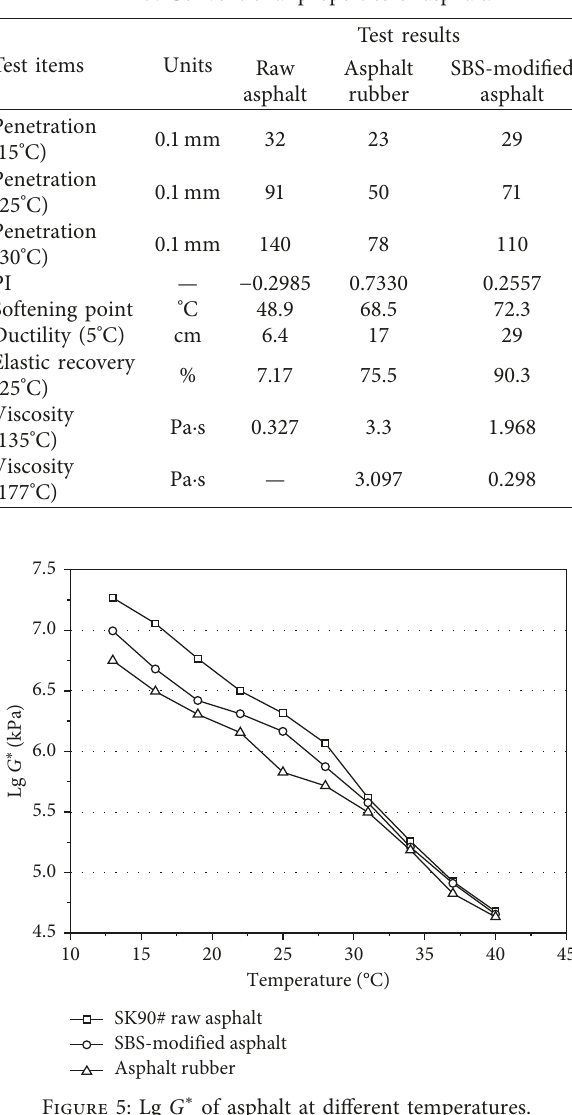
sin δ ) of asphalt at different · ∗